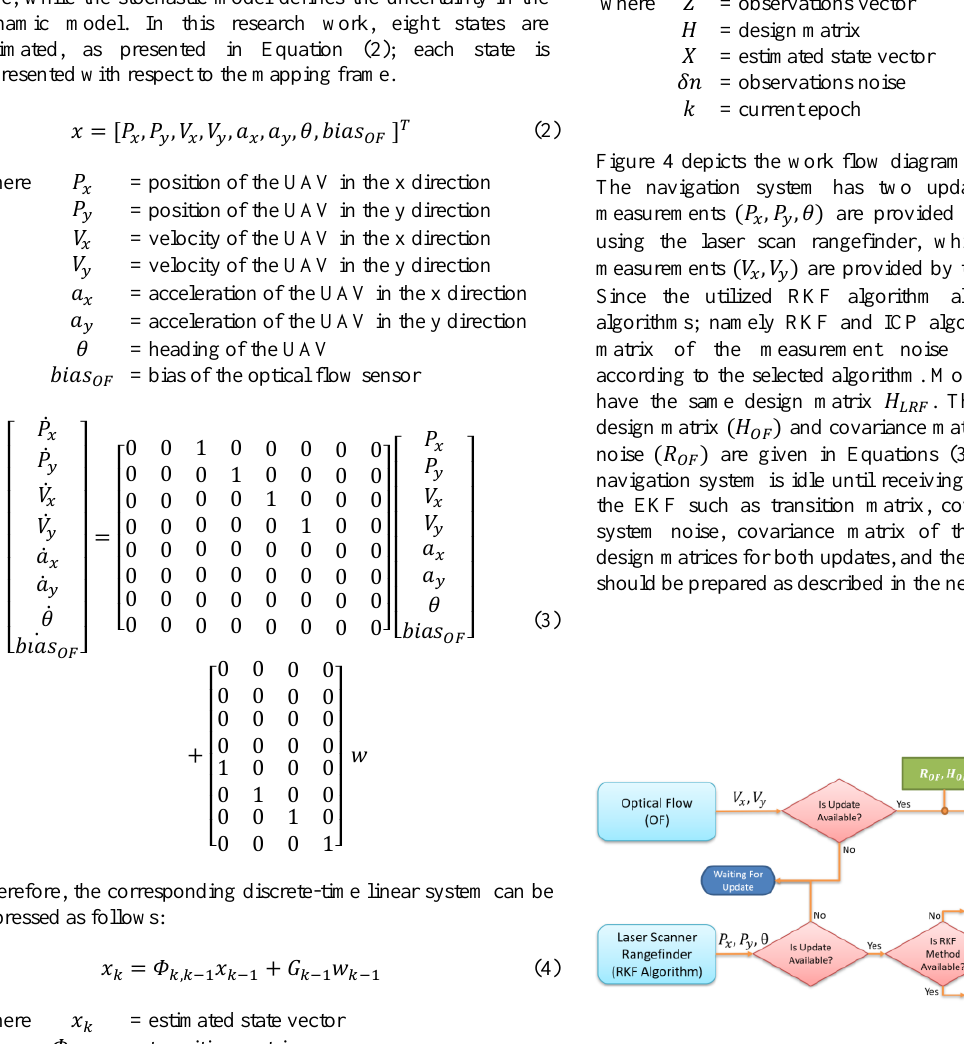
Figure 4. EKF work flow